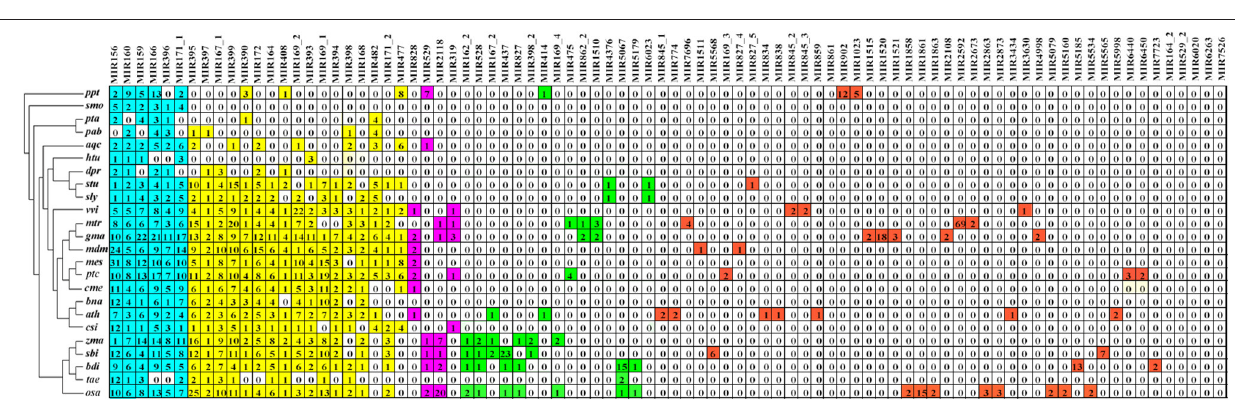
FIGURE 3 | Comparison of 86 known miRNA families in Lilium pumilum DC. Fisch. and their homologs in 24 land plants. Known miRNA families of Lilium identified from small RNA sequencing are listed in the top row. The number in each well corresponds to the related miRNA family size obtained from miRBase v21. The colors represent relative miRNA families classified into different groups with similar conservation. Blue, yellow, purple, green and red represent relative miRNA families with homologs across more than 20, 10-19, 5-9, 2-4, and 1 plant species, respectively. Ppt , Physcomitrella patens ; smo , Selaginella moellendorffii ; pta , Pinus taeda ; pab , Picea abies ; aqc , Aquilegia caerulea ; htu , Helianthus tuberosus ; dpr , Digitalis purpurea ; stu , Solanum tuberosum ; sly , Solanum lycopersicum ; vvi , Vitis vinifera ; mtr , Medicago truncatula ; gma , Glycine max ; mdm , Malus domestica; mes , Manihot esculenta ; cme , Cucumis melo ; ptc , Populus trichocarpa ; bna , Brassica napus ; ath , Arabidopsis thaliana ; csi , Citrus sinensis ; zma , Zea mays ; sbi , Sorghum bicolor ; bdi , Brachypodium distachyon ; osa , Oryza sativa ; tae , Triticum aestivum